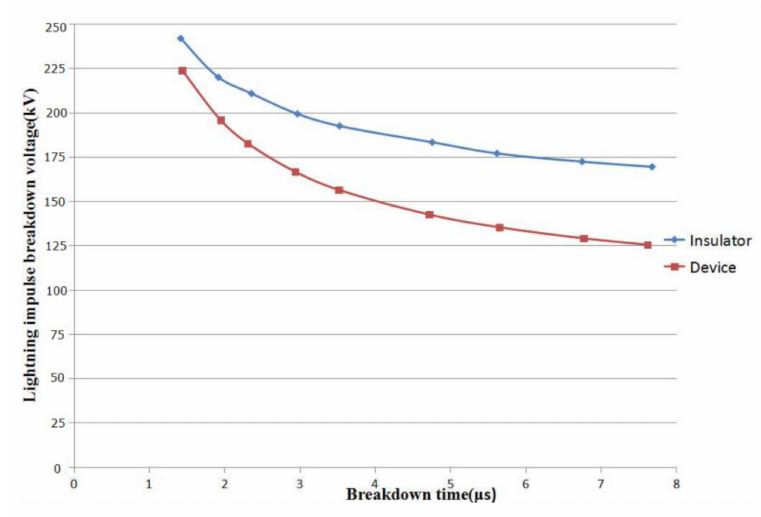
Figure 10. V-t curves of the insulator and device.